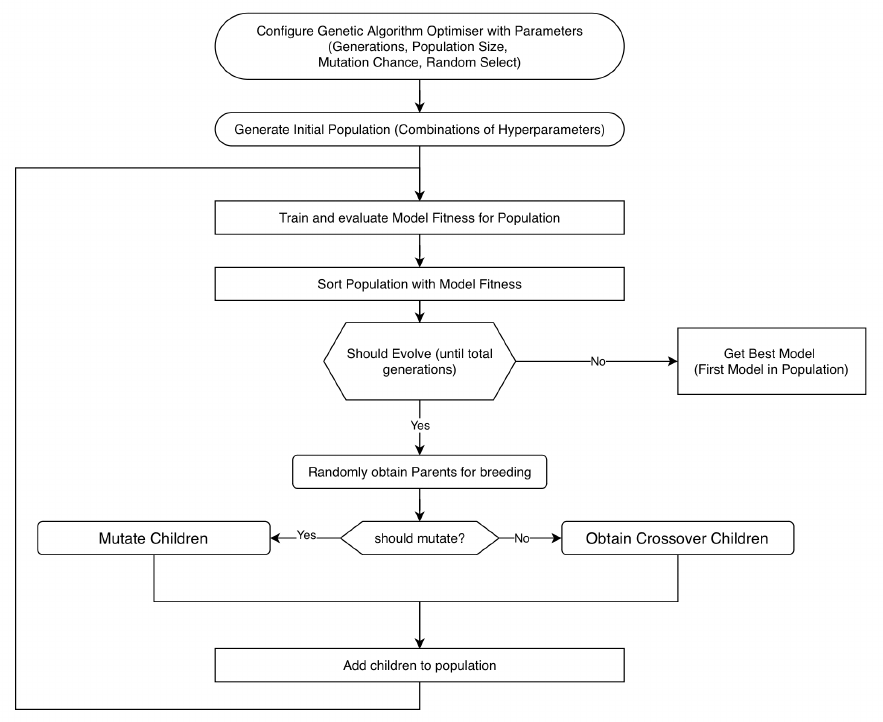
Figure 4. Flowchart of GAO-algorithm for tuning hyperparameters of LSTM